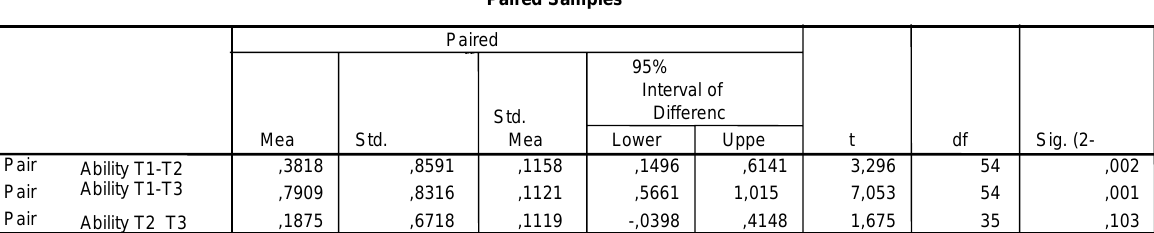
Ability to Function (Work, Social, Love, and Sex) as Measured with Four Questions on a 5-point Likert Scale Significantly Improved with Clinical Holistic Medicine Paired